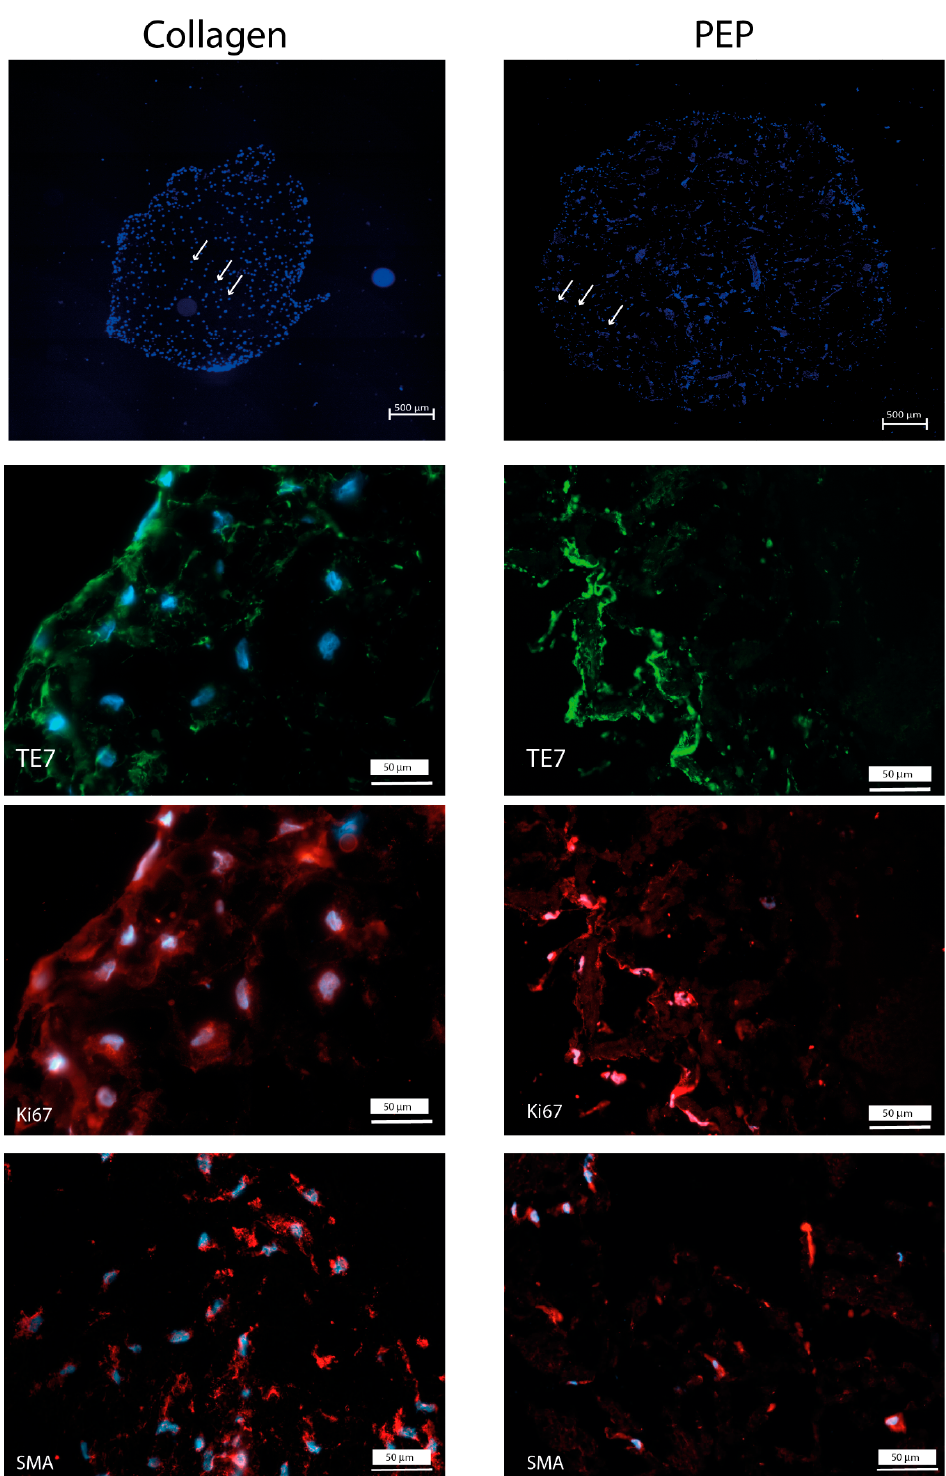
Figure3. Sca ff oldwithcollagen(leftpanel)andwithPEP(rightpanel)stimulatethegrowthoffibroblasts. Fibroblasts cells were cultured for one week, and further examined by immunohistochemistry. Expression of fibroblast marker TE7 (light green), proliferation marker KI67 (red), and fibroblast di ff erentiation marker SMA (red). Cell nucleus outlined by Hoechst-staining